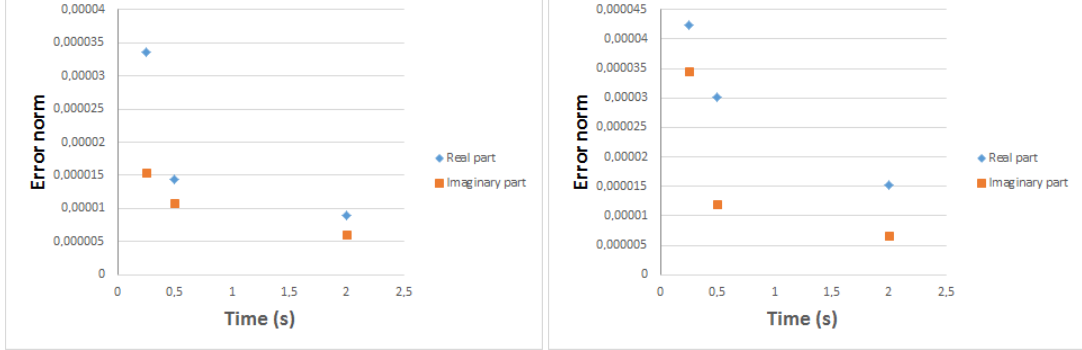
Figure 7. l 2 and l ∞ norms of the errors of the real and imaginary parts Example 3, respectively versus